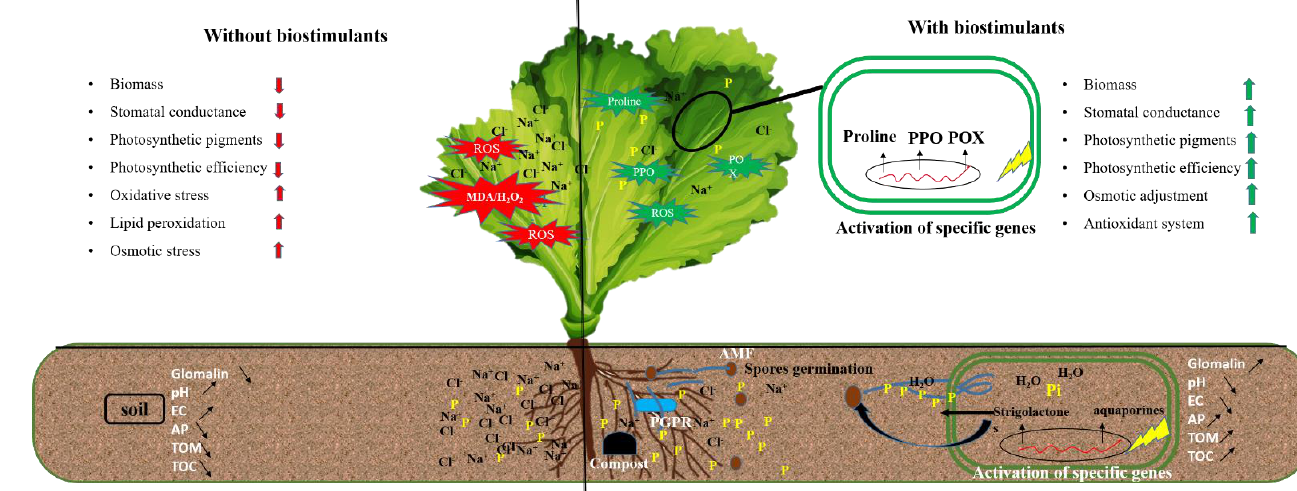
Figure 11. Diagrams summarizing the effects induced by biostimulants (PGPR, AMF, and compost) leading to the tolerance of lettuce to salt stress. POX: peroxidase activity; PPO: polyphenol oxidase; EC: electrical conductivity; AP: soil available phosphorus; TOM: total organic matter; TOC: total organic